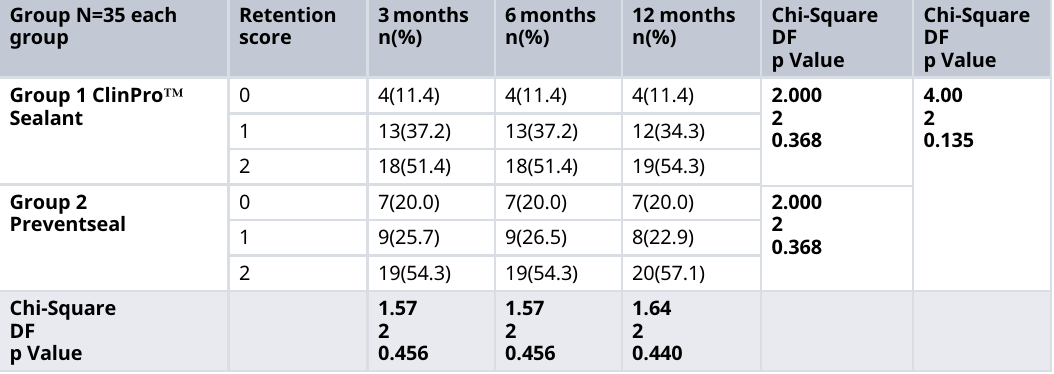
Table 1. Intergroup comparison of Simonsen ’ s Score for sealant retention between ClinPro ™ Sealant and Preventseal at 3, 6, and 12 months. Group N=35 each Retention 3months group score n(%)